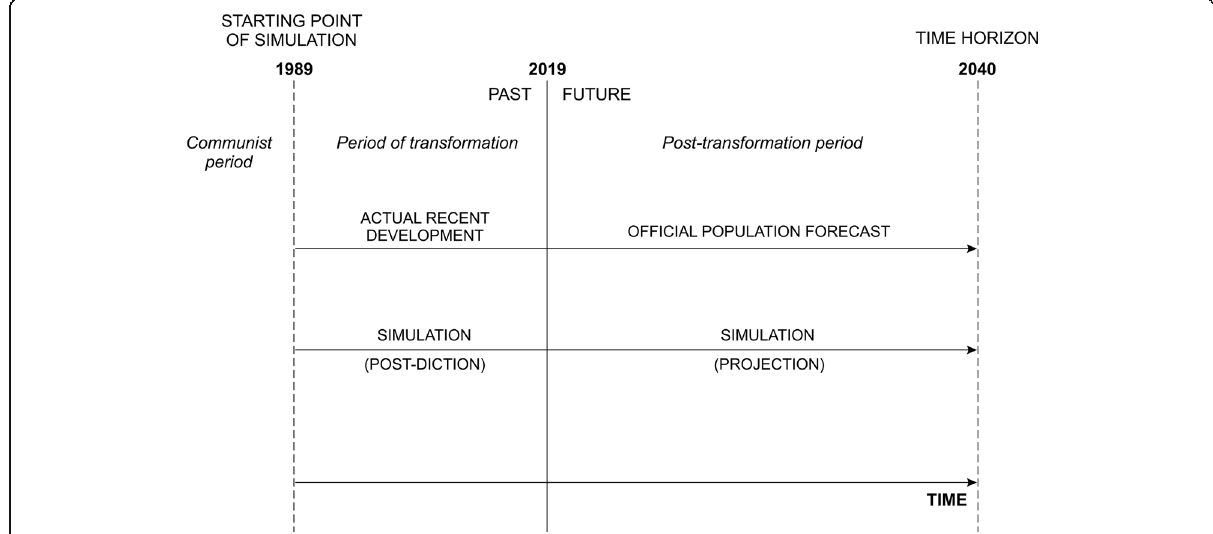
Fig. 1 The conceptual framework of the simulation. Source: